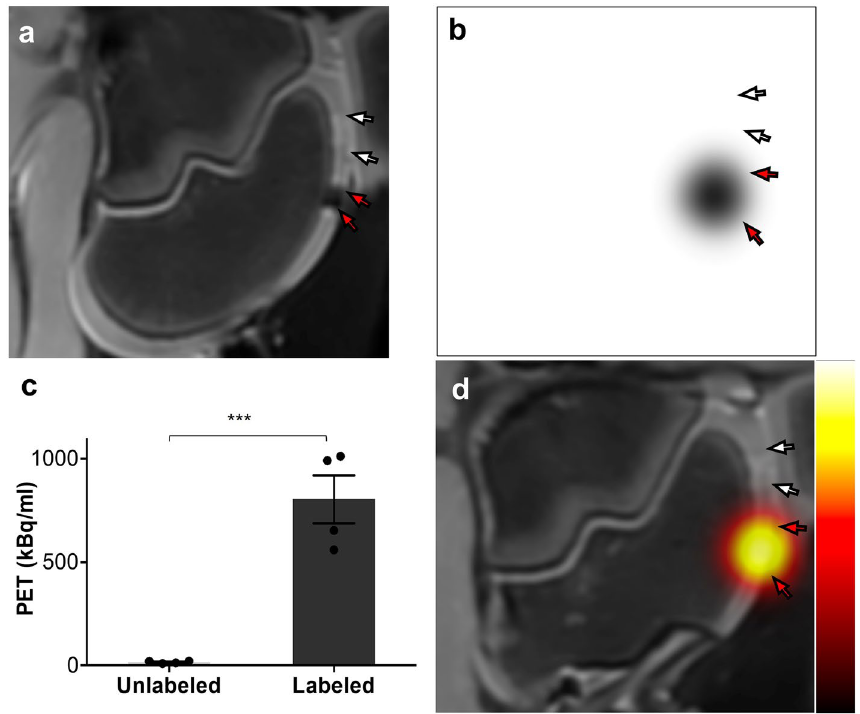
Figure 5. Ex vivo PET/MRI imaging of ADSCs implantation in pig knee. ( a ) MR image showing significant signal loss near labeled ADSC implant (red arrows) compared to unlabeled implant (white arrows). ( b ) Clear PET signal is also observed near the labeled ADSCs (red arrows) but not for the unlabeled implant (white arrows). ( c ) PET quantification showing significantly higher radioactivity in the labeled implant. ( d ) Fused PET/ MR images showed co-localization of PET and MR signals (red